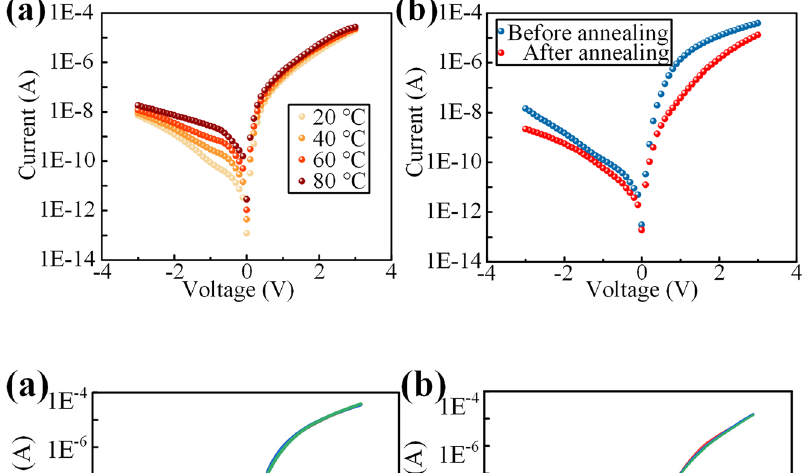
Figure 4: (a) The temperature-dependent current – voltage measurements of Ti 3 C 2 T x / p-Si Schottky junction in the dark. (b) The current – voltage characteristics of the Schottky photodetector in the dark before and after vacuum annealing.